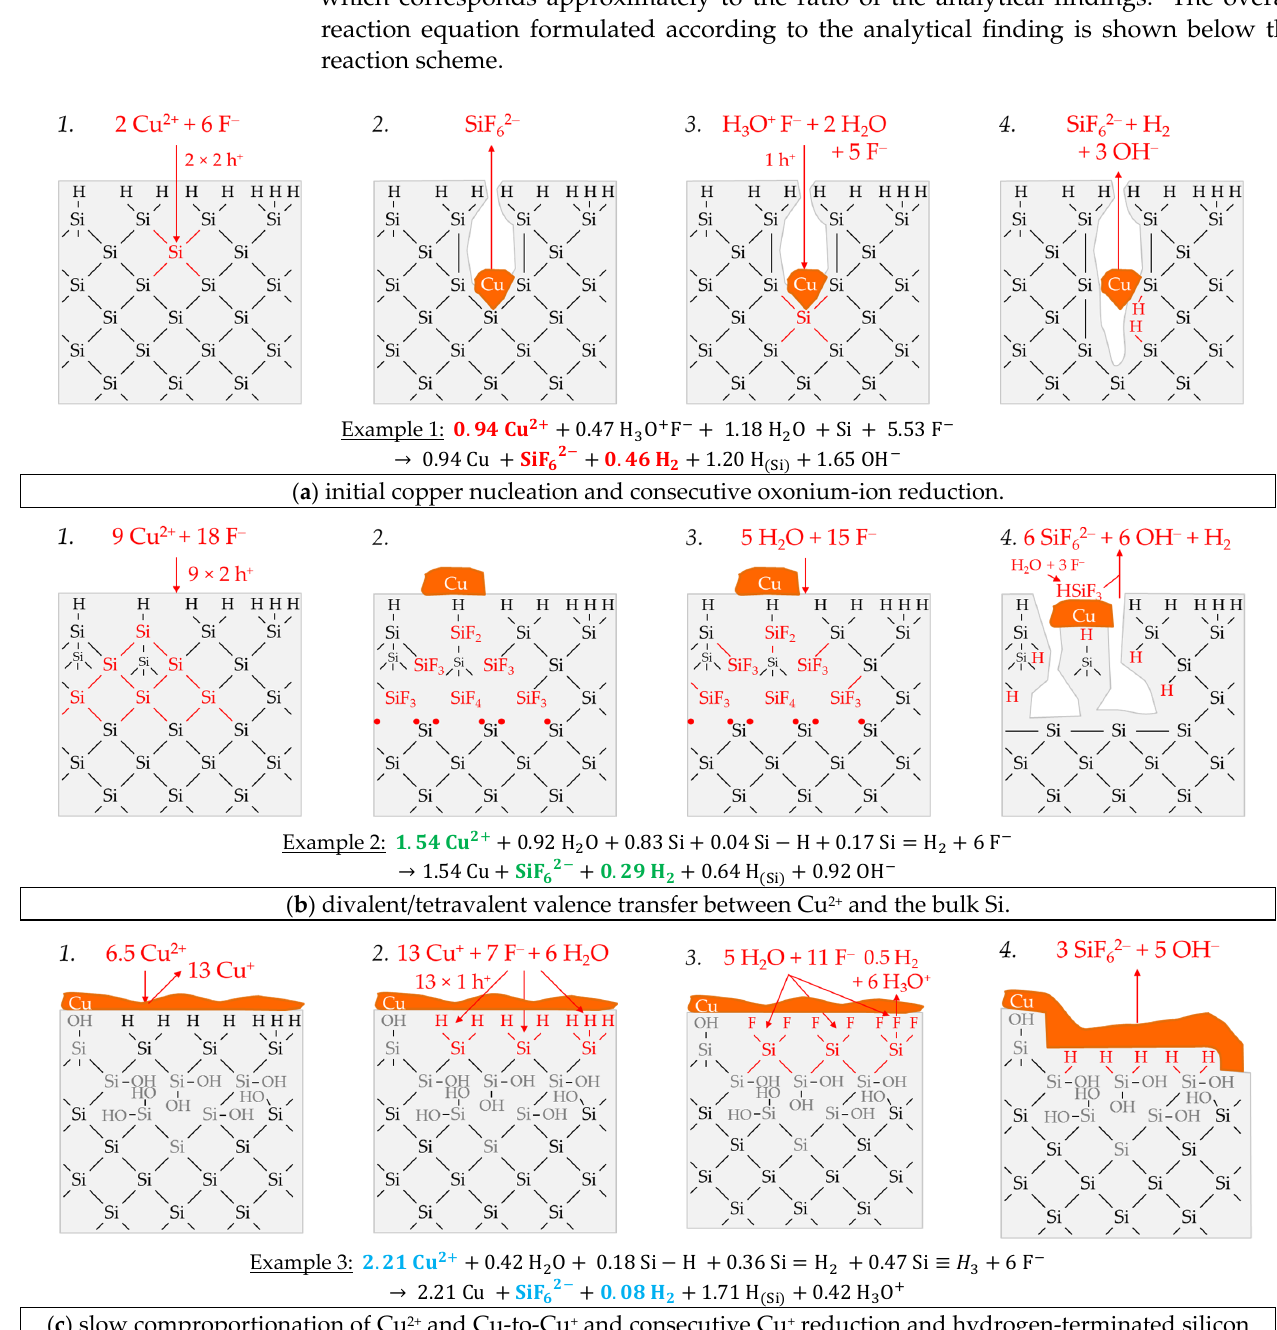
Figure 7. Schematic reaction process and balance of the copper deposition on silicon, based on the examples marked in Figure 6e,f. ( a ) Example 1: the copper nucleation and consecutive oxonium-ion reduction, ( b ) example 2: the valence exchange between Cu 2+ and the bulk Si, and ( c ) example 3: the valence exchange between Cu + and the hydrogen-terminated silicon.